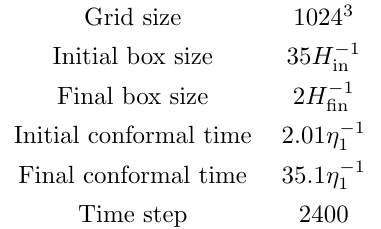
Table 1 . Simulation parameters. H in ( H (cid:12)n ) are the Hubble parameter at the initial ((cid:12)nal) time. Here, H = aH denotes the conformal Hubble parameter, i; j; k = 1 ; 2 ; 3, and the dot denotes the derivative with respect to the conformal